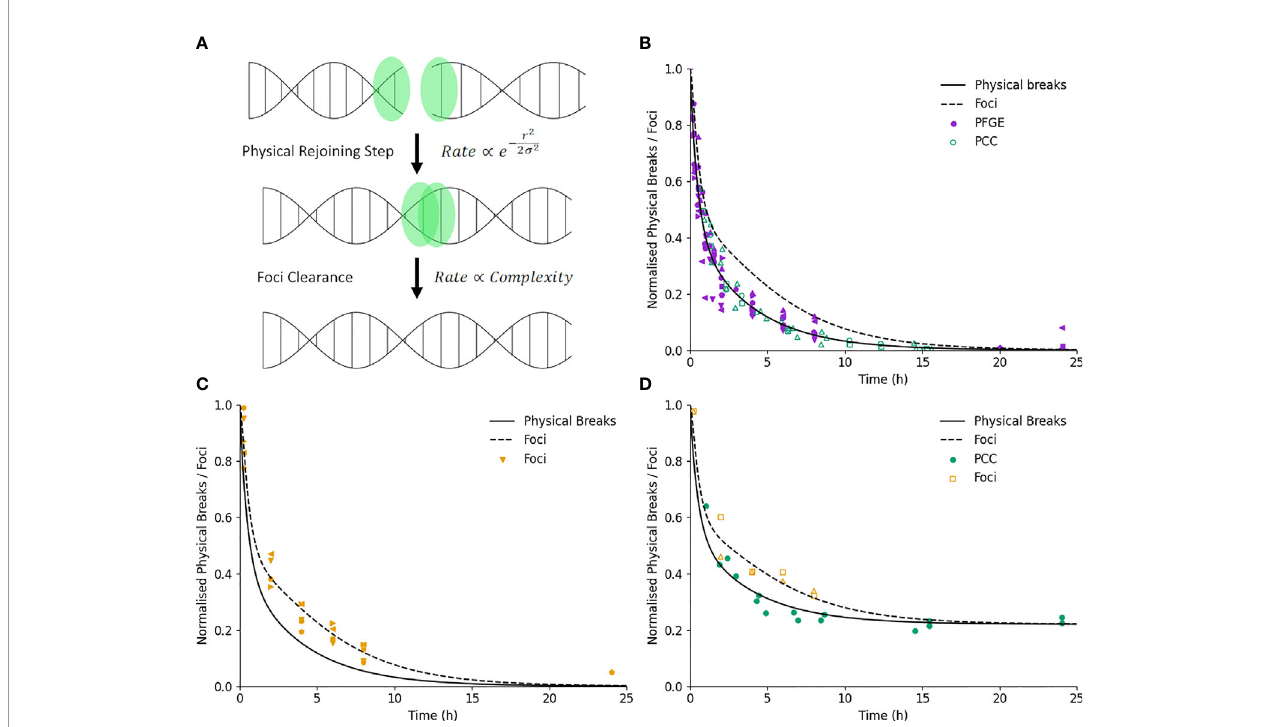
FIGURE 2 | Illustration of DNA repair kinetics. (A) Key modelled stages in DNA repair. Break ends are initially free, and interact physically with a nearby end with a rate which is related to the break complexity and initial separation. Once joined, the associated foci is cleared after a delay which depends only on break complexity. (B) Break kinetics for physical breaks and foci (solid and dashed line) in normal cells. Points represent measured breaks via PFGE (solid) and PCC (open). Error bars not shown for clarity. (C) Break kinetics compared to measurements via foci (points) illustrating impact of foci clearance on repair kinetics. (D) Measurements of repair in ATM-defective lines for both physical breaks ( fi lled) and foci (open), showing similar impact on kinetics and fi nal breaks for both